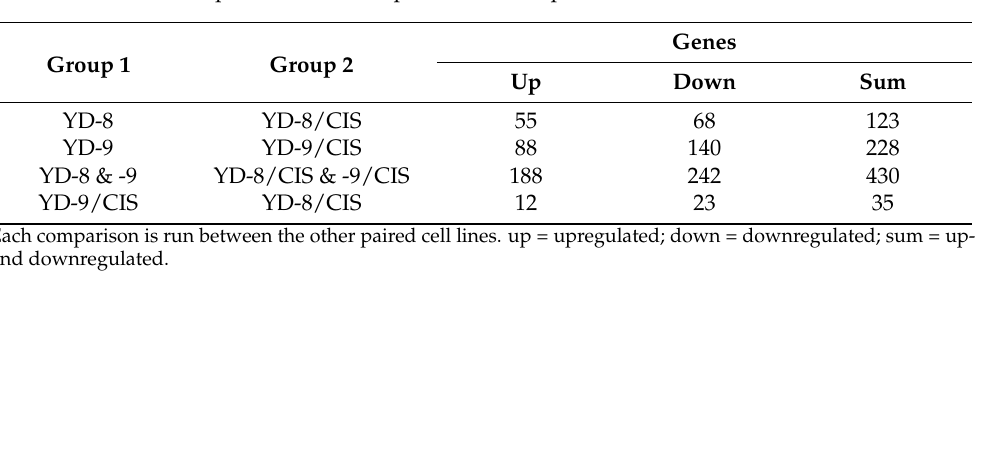
Table 4. Differential expression between parental and cisplatin-resistant cell line libraries.